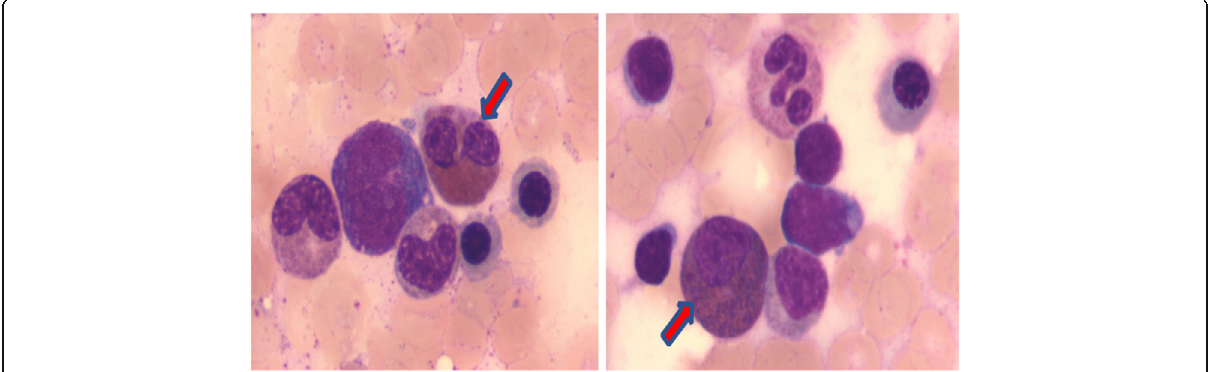
Fig. 2 Bone marrow aspirate smear analysis shows eosinophilia. Eosinophils are indicated by